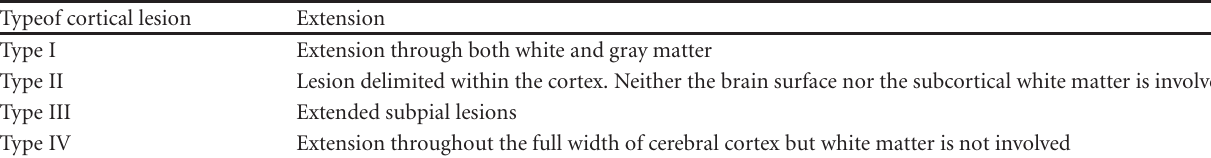
Table 5: Types of cortical lesions described by B ∅ et al. 2003